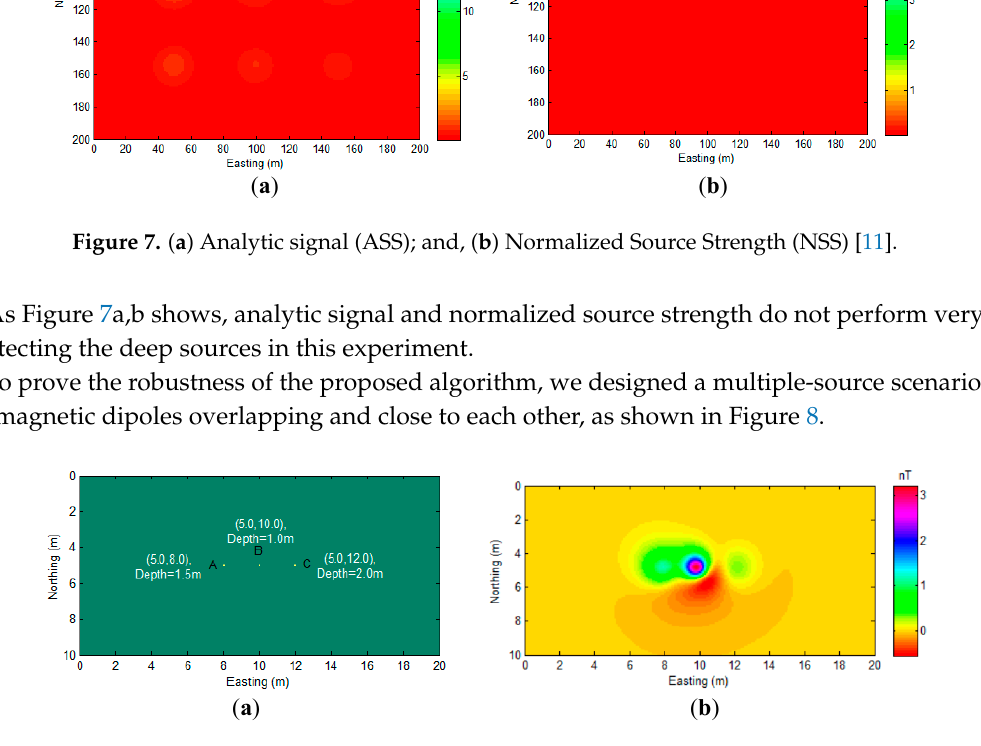
; dipole moments are 20 Am 2 ; and ( b )